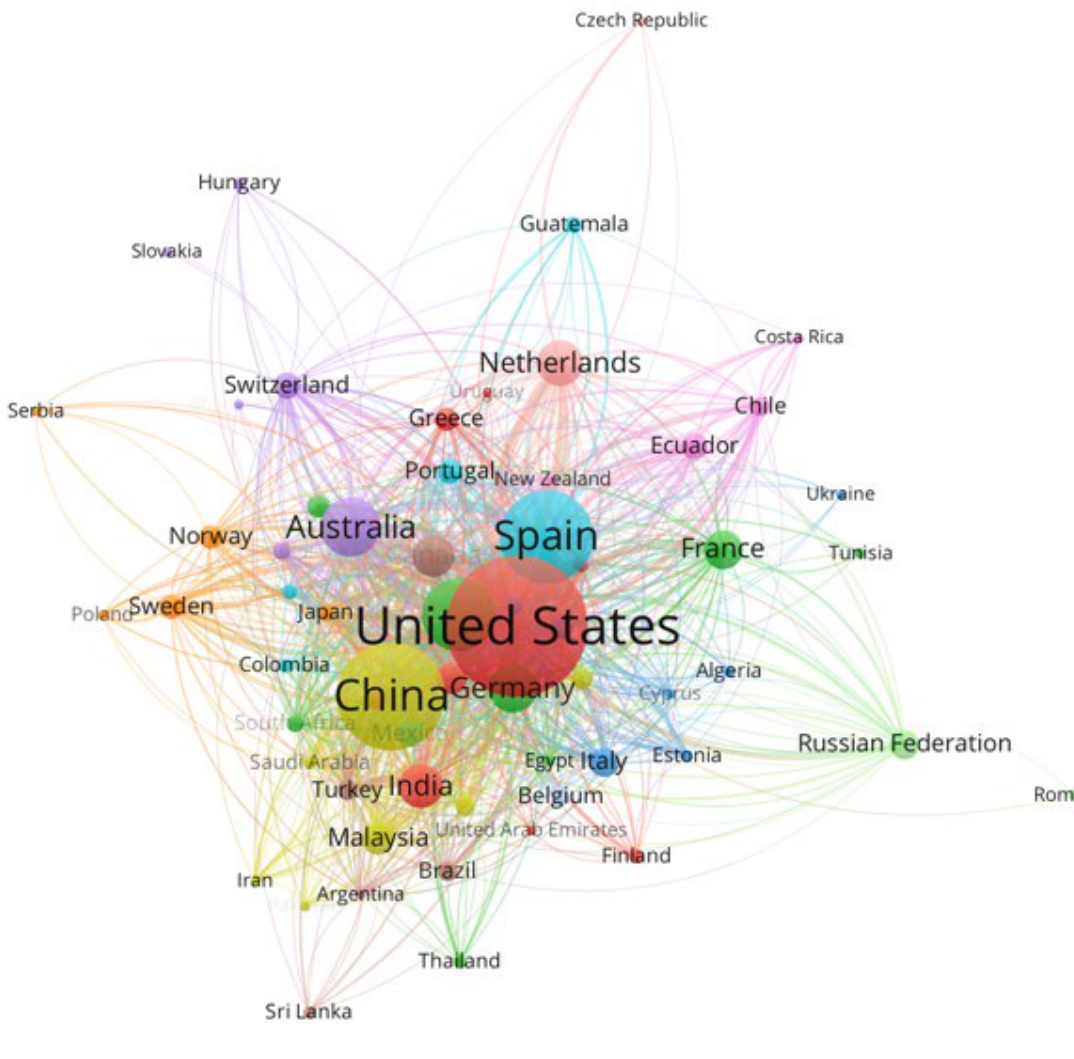
Figure 6. Network visualization map of citations of MOOCs documents by country, with a minimum of five documents per country and a minimum of five citations per